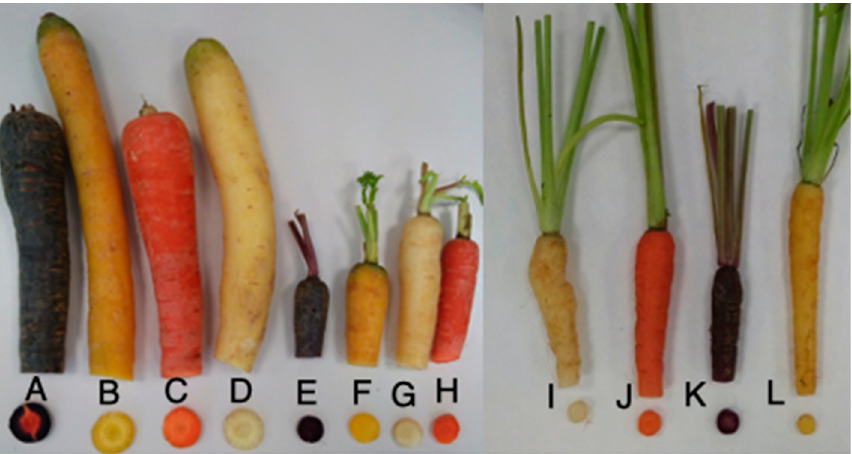
Figure 1. Types of carrots and varieties (A—normal purple carrot (NPC), B—normal yellow carrot (NYC), C—normal orange carrot (NOC), D—normal white carrot (NWC), E—mini purple carrot (MiPC), F—mini yellow carrot (MiYC), G—mini white carrot (MiWC), H—mini orange carrot (MiOC), I—micro white carrot (MWC), J—micro orange carrot (MOC), K—micro purple carrot (MPC), L—micro yellow carrot (MYC)).